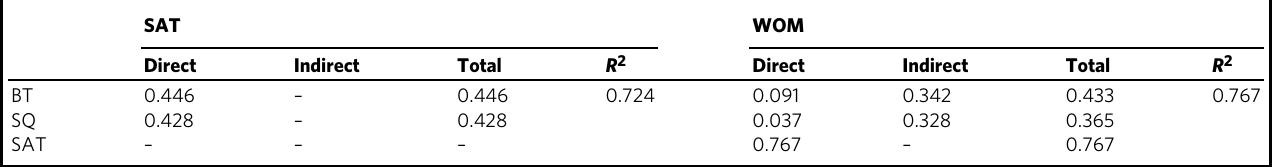
Table 6 Direct, indirect and total effect of the constructs of the present study.